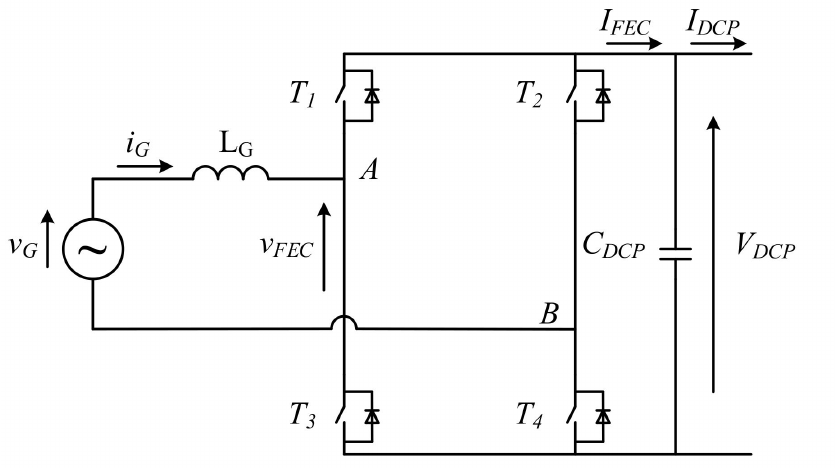
Figure 6. Grid-side of the BWV2H with convention of the current according to charging